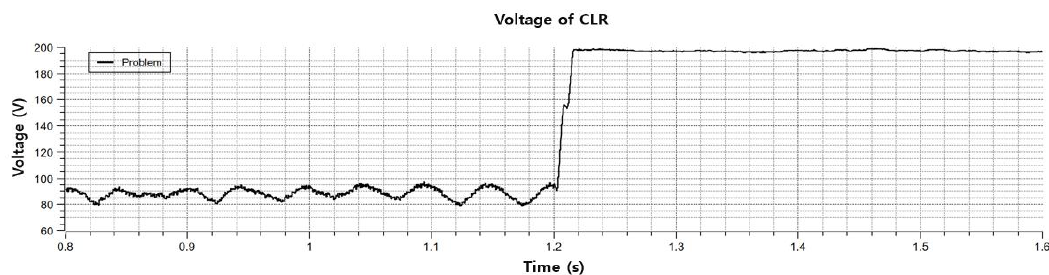
Figure 12. GPT zero-phase voltage when connecting existing IMD and GPT.